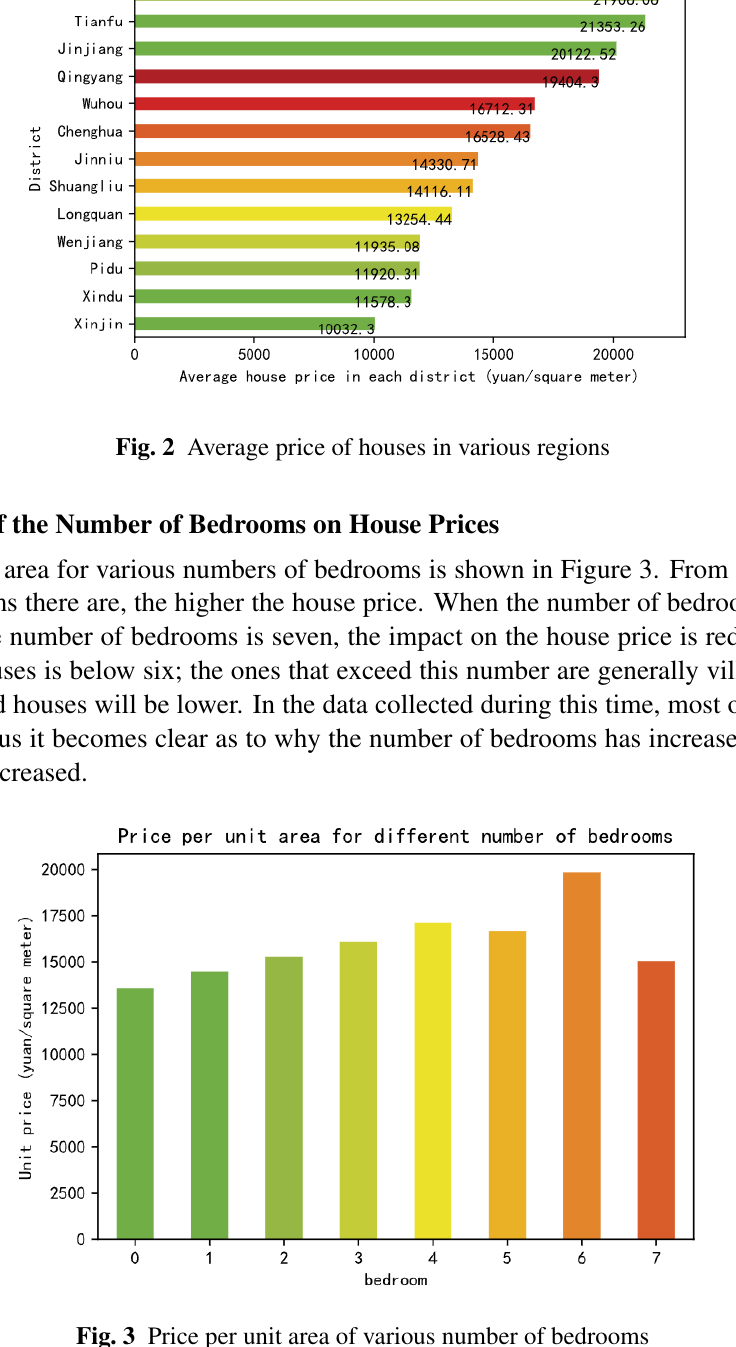
Fig. 3 Price per unit area of various number of